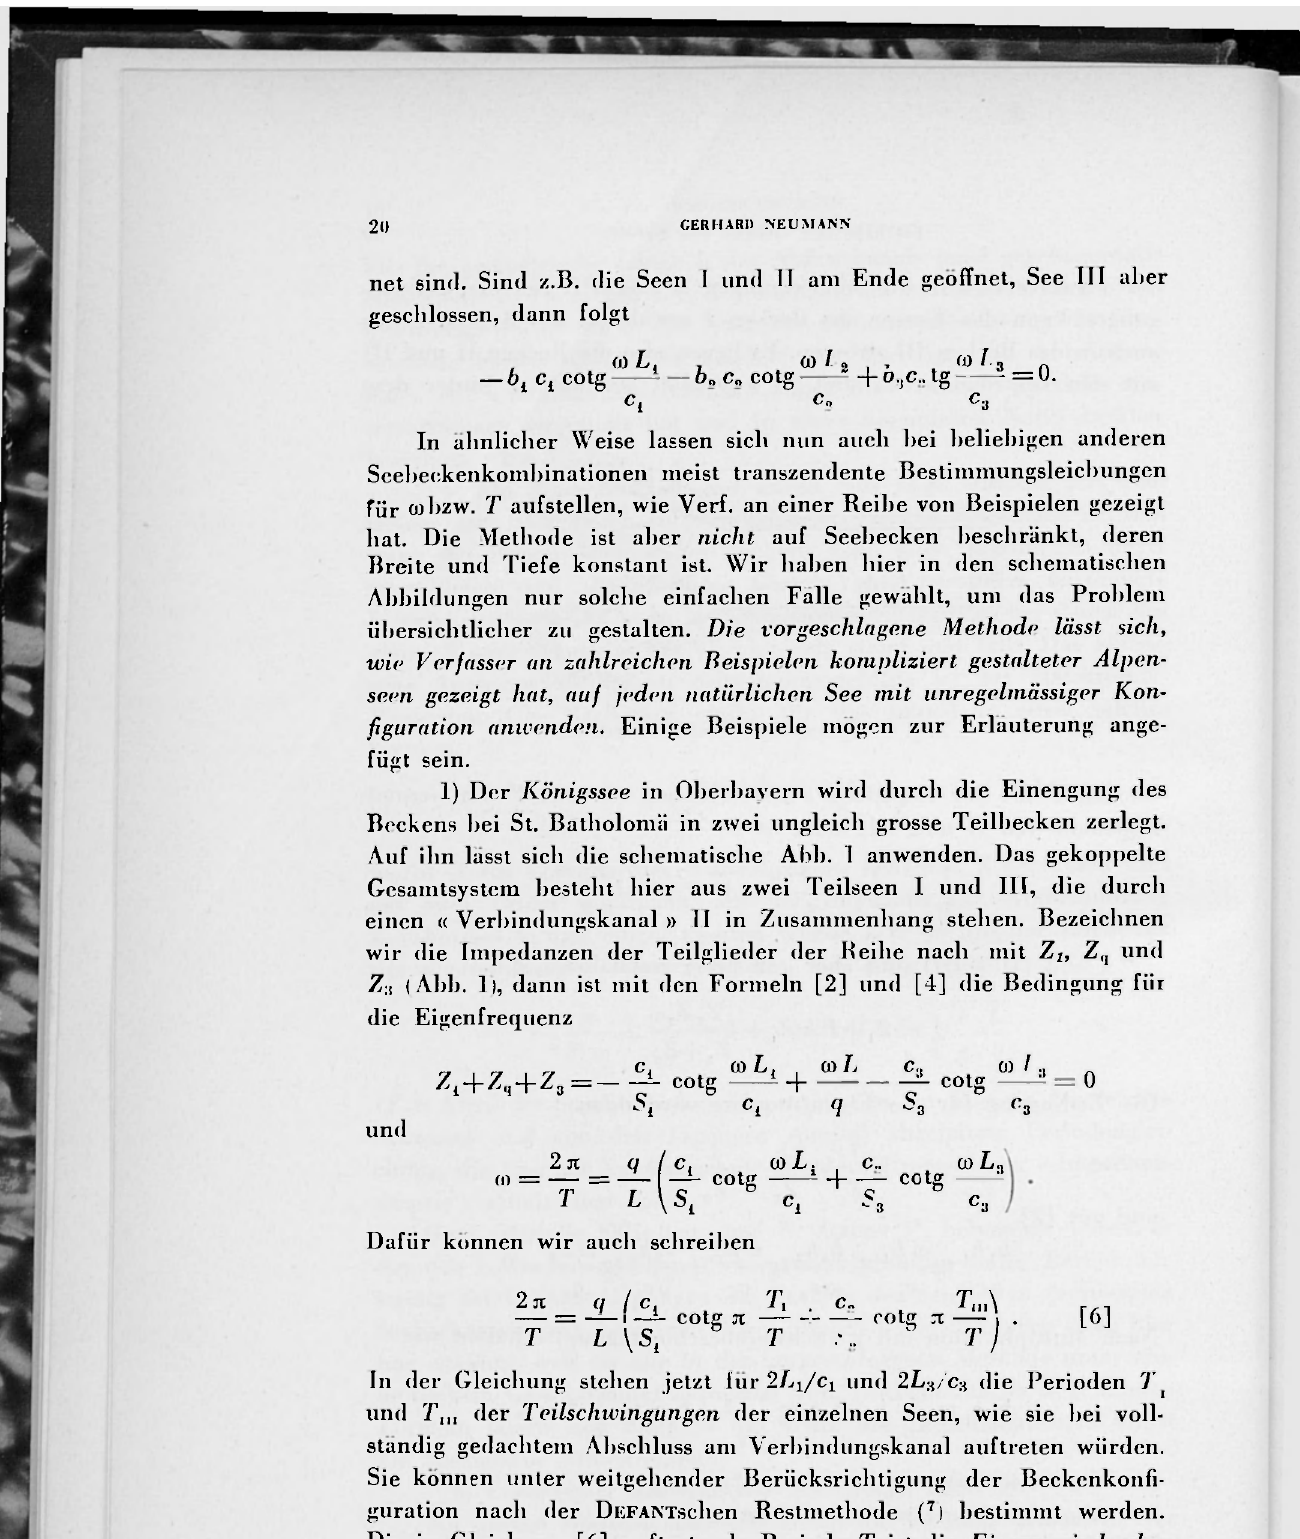
figuration anivenden. Einige Beispiele mogen zur Erlauterung ange- fiigt